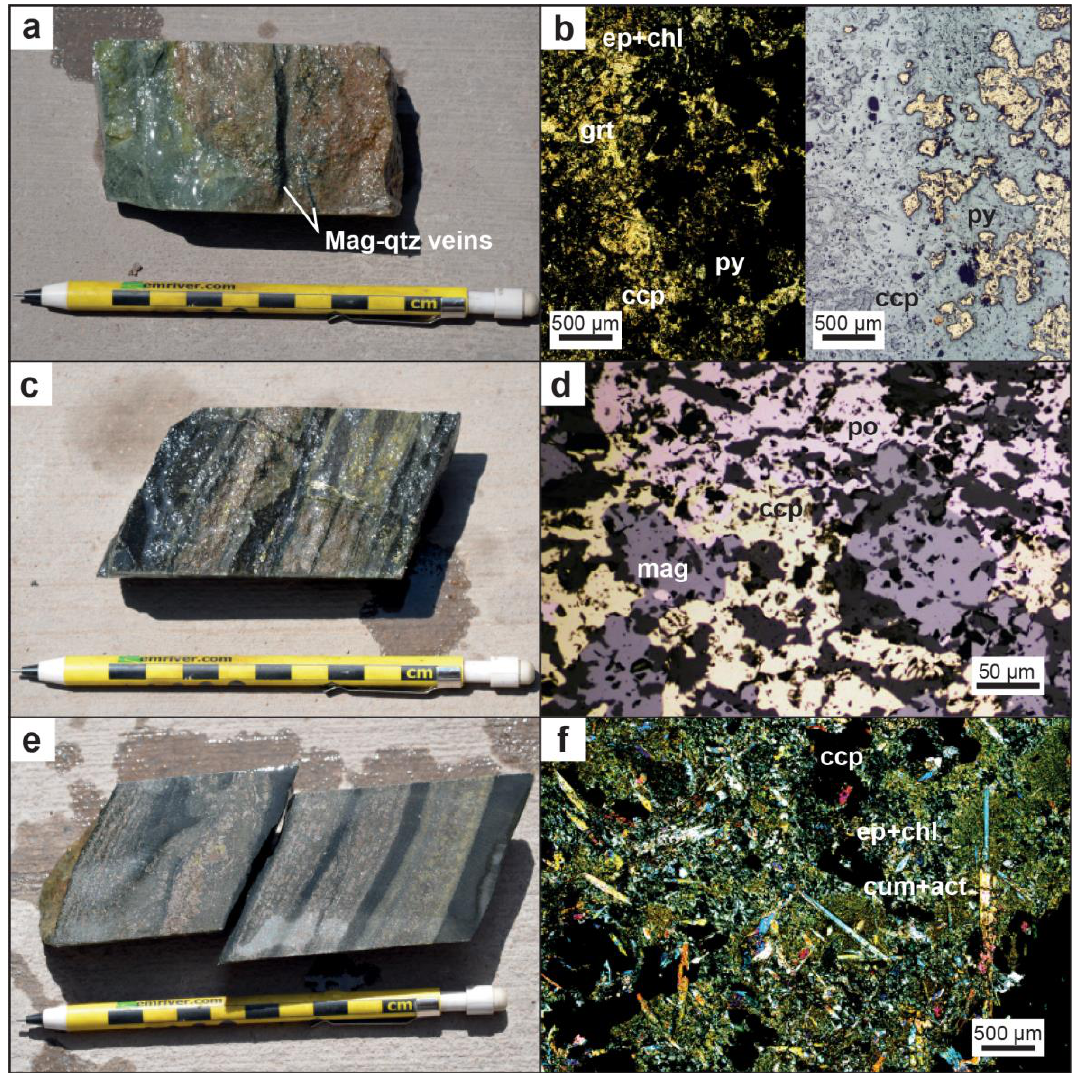
Figure 4. Examples of skarn from the Don Manuel core. ( a ) Garnet-clinopyroxene-epidote skarn from drill hole DM7, 597 m (DM7AG21). ( b ) Photomicrograph of sample DM7AG21 in plane (left) and reflected (right) light showing anhedral andradite overprinted by epidote, chlorite and chalcopyrite. ( c ) Finely layered sediments with calc-silicate layers that have been selectively altered to clinopyroxene-magnetite-actinolite-epidote skarn with some layers being replaced by abundant sulfides, DM7, 582 m (DM7AG20). ( d ) Photomicrograph of the massive sulfide layer in sample DM7AG20 in reflected light containing magnetite, chalcopyrite, and pyrrhotite. ( e ) Clinopyroxene-actinolite-epidote skarn from drill hole DM7, 201 m. ( f ) Photomicrograph of retrograde skarn assemblage with acicular cummingtonite overprinted by actinolite with fine-grained chlorite-epidote-chalcopyrite (DM7AG08) in cross-polarized light. Mineral abbreviations: act = actinolite, chl = chlorite, ccp = chalcopyrite, cum = cummingtonite, ep = epidote, grt = garnet, po = pyrrhotite, and py = pyrite. (mag = magnetite, qtz = quartz)